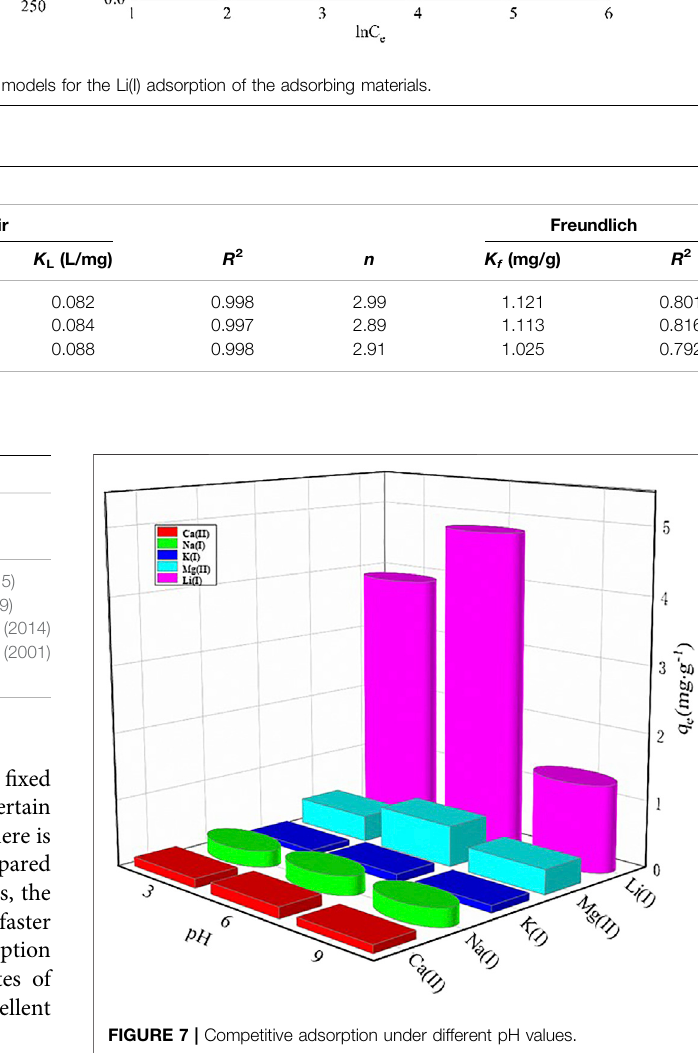
FIGURE 7 | Competitive adsorption under different pH